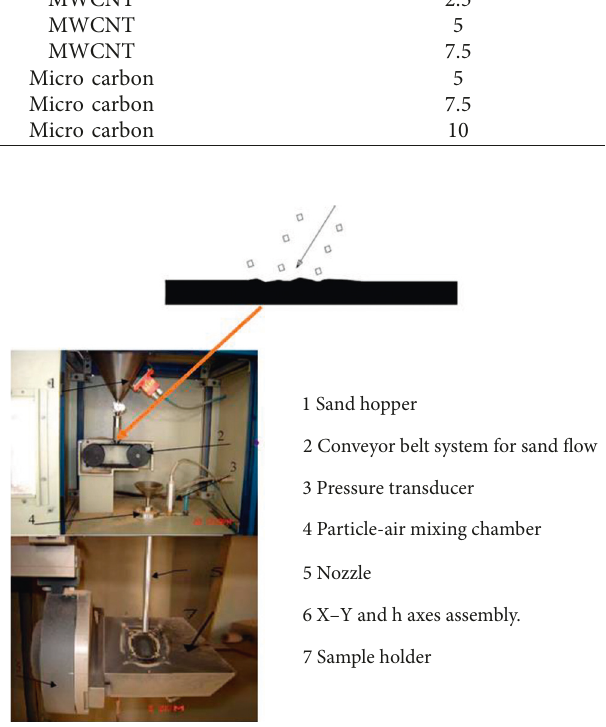
Figure 2: Erosive wear mechanism (top) and erosion test setup